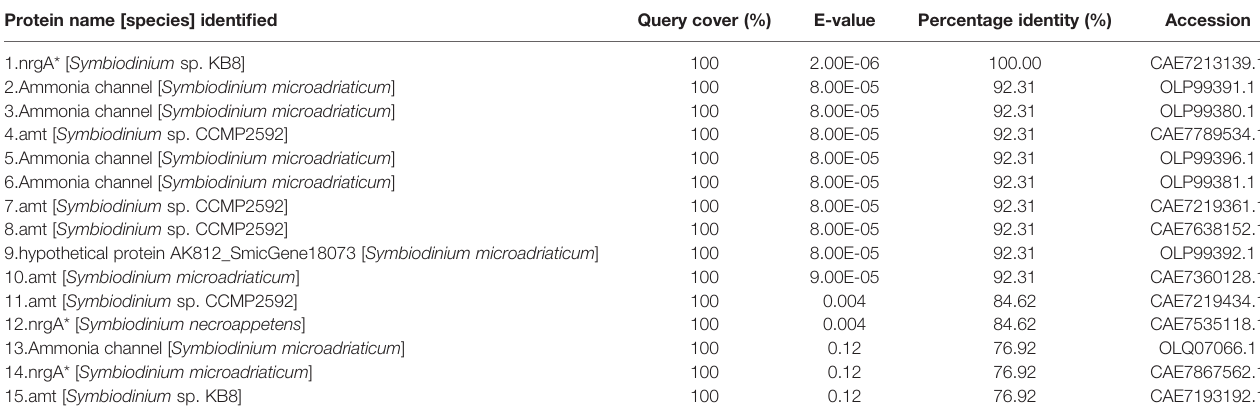
TABLE 2 | BLAST analysis of the epitope sequence (YSFWTNLDMKNWD) of the genus-comprehensive anti-Zoox-AMT2 antibody. Protein name [species] identi fi